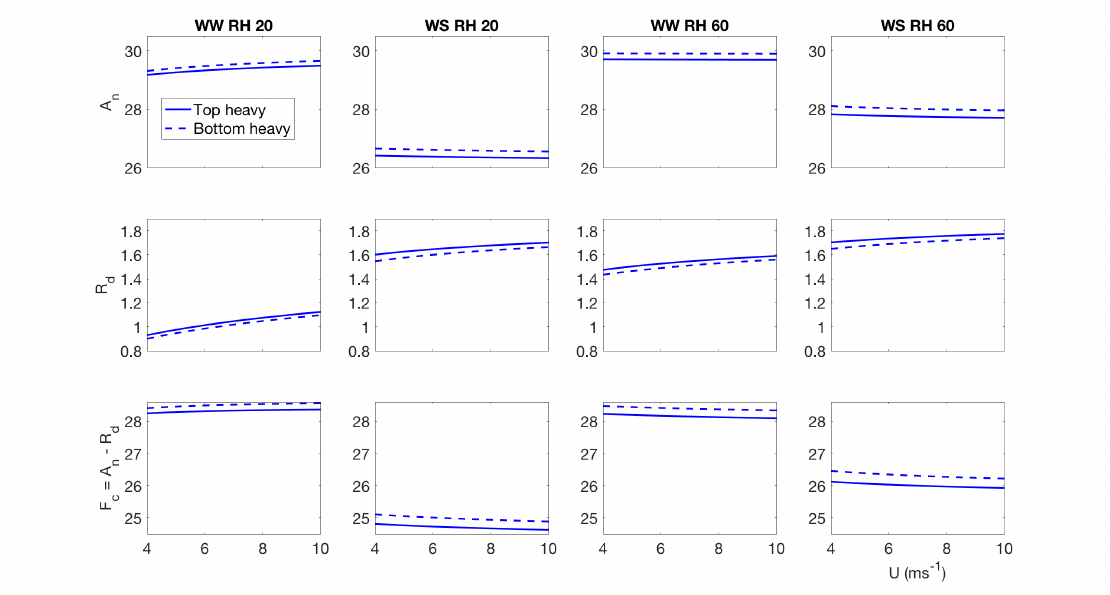
Figure 13. Similar to Figure 12 but for the higher light